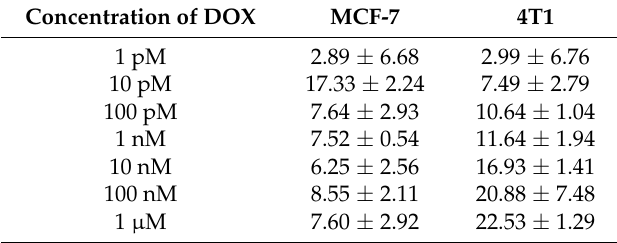
Table 3. Enhancement of cytotoxicity (%) for DOX-loaded SMCA (Succinate-modified carbonate apatite)